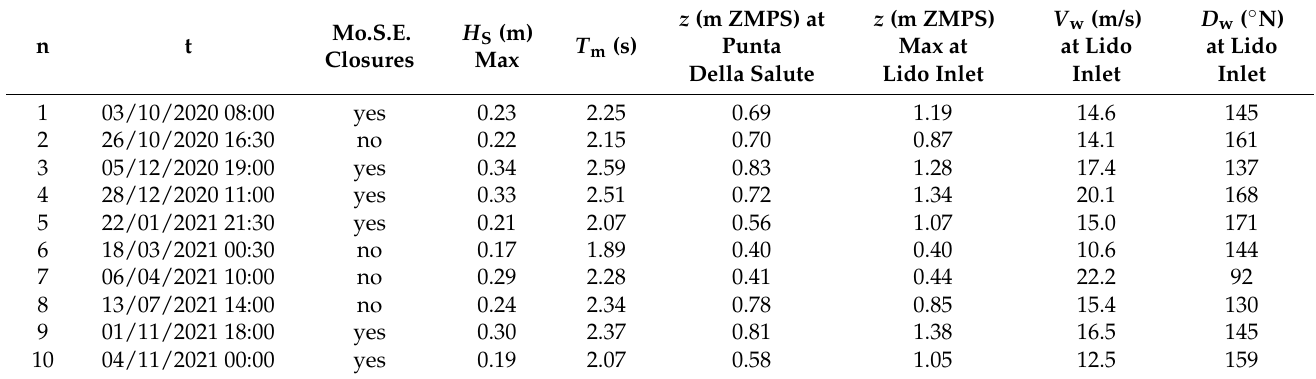
Table 1. List of stormy events (6 during Mo.S.E. closures and 4 during ordinary events) that force the wind-wave generation in front of the San Marco square.